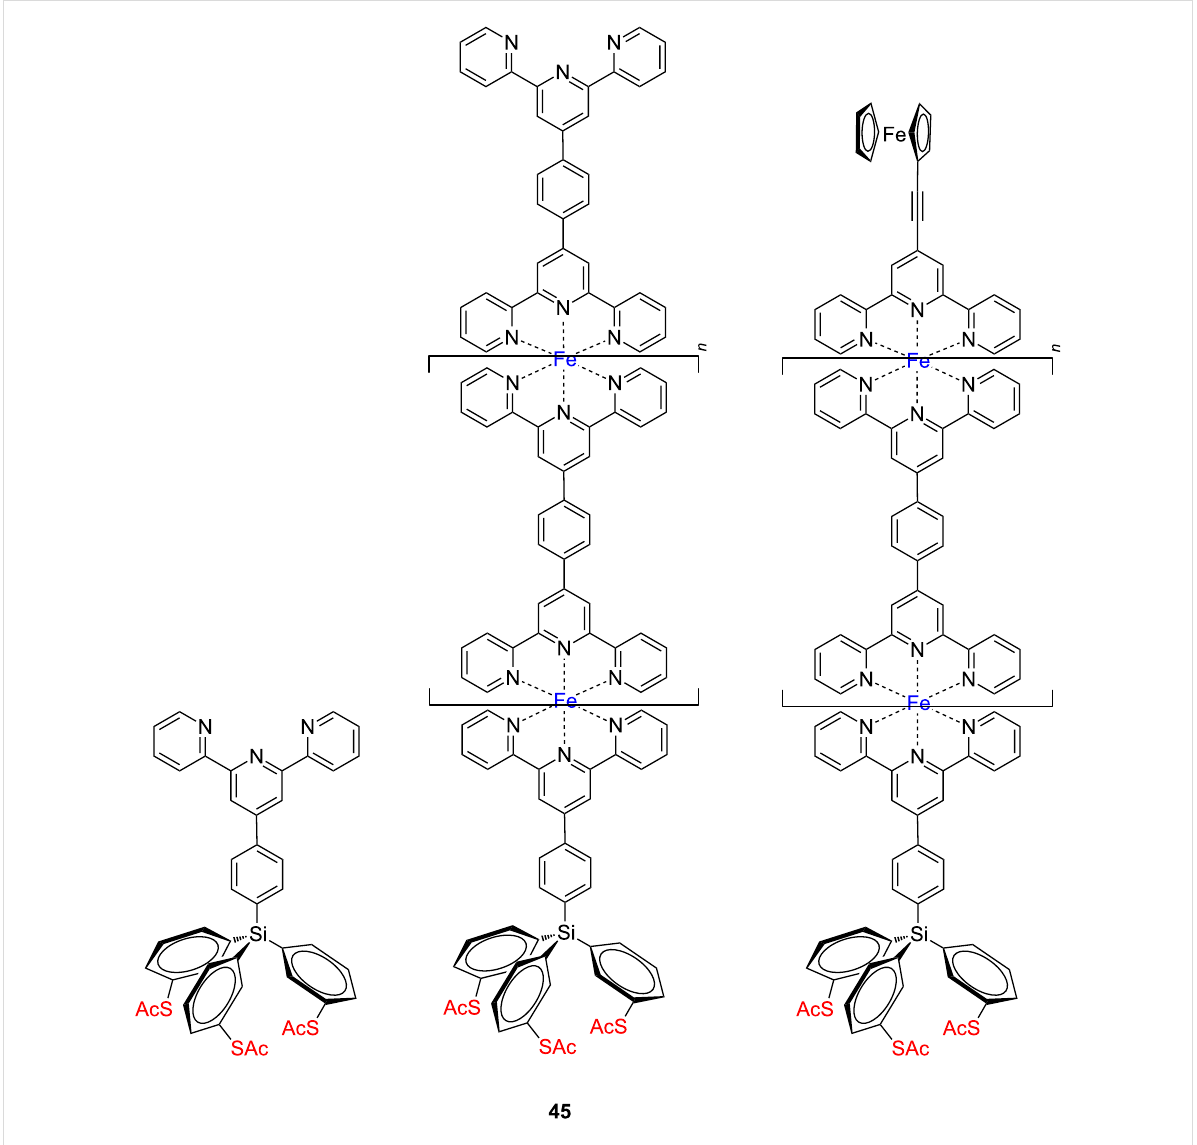
Figure 23: Bis(terpyridine)–Fe(II) oligomer wires terminated with a tripodal scaffold 45 .